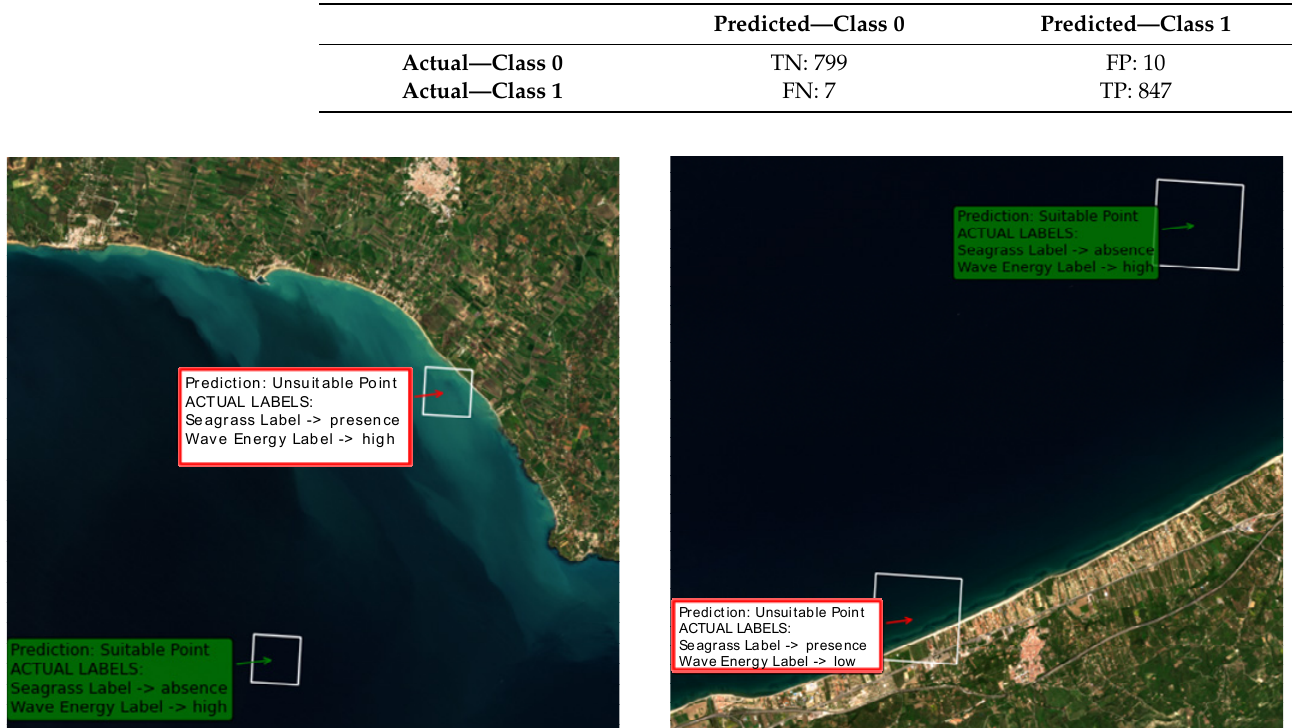
Figure 8. Data Fusion based Neural Network performance during training process. ( a ) Binary Cross Entropy Loss for both training (orange) and validation (blue) datasets; ( b ) F1 score for both training and validation datasets. Table 5. Confusion Matrix of Neural Network that classifies the suitability of potential WEC installa- tion regions.